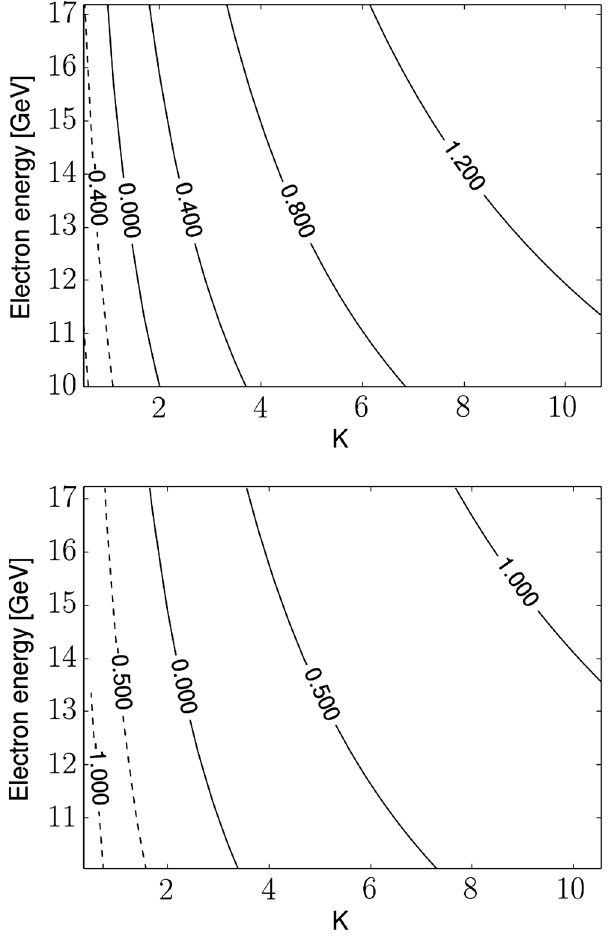
m.FIG. 1. Diffusion coefficients for SASE XFEL undulators in units of log 10 of energy broadening [MeV] per 100 m. The upper plot corresponds to l w ¼ 0 . 04 m and the lower to l w ¼ 0 . 068 m. Dashed lines correspond to negative exponent